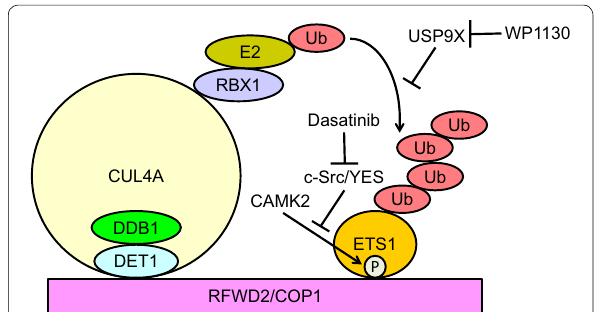
Fig. 2 The complex containing RFWD2/COP1 mediates ubiquitina- tion of ETS1. The E3 ubiquitin ligase RFWD2/COP1 recognizes ETS1 in a CAMK2-mediated Ser276 and Ser282 phosphorylation-dependent manner. Src or YES1 phosphorylates ETS1 at Tyr283, which reverses CAMK2-dependent destabilization of ETS1 protein. The deubiquit- inase USP9X prevents EST1 ubiquitination and stabilizes the protein. Thus, dasatinib and WP1130 (Src and USP9X inhibitors, respectively) might target ETS1 for proteolysis